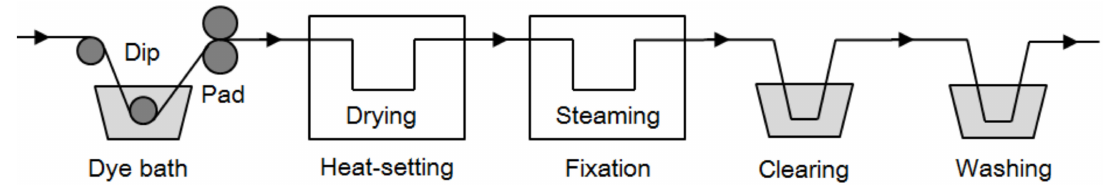
Figure 2. Dyeing process of azo-anthraquinone reactive